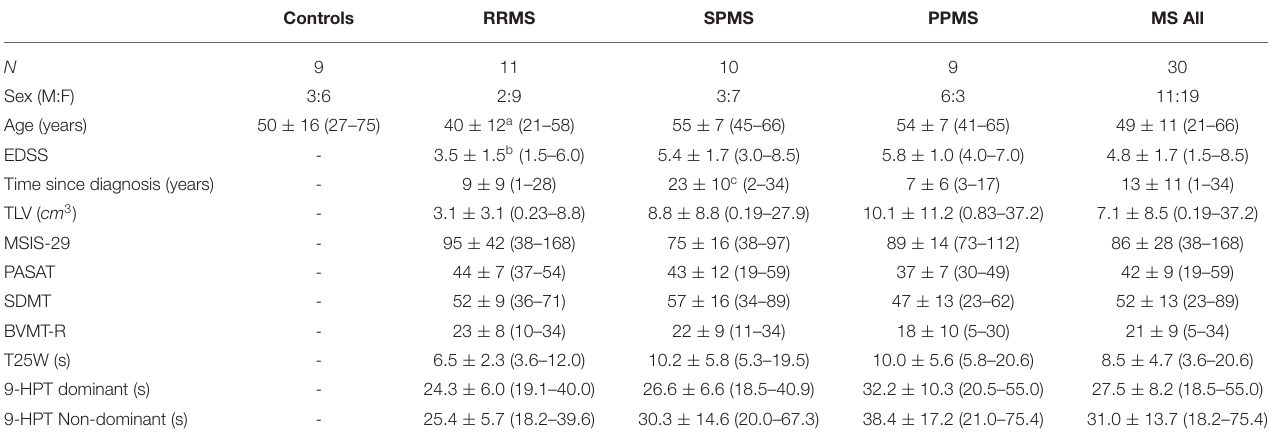
TABLE 1 | Participant demographics expressed as mean ± SD with (min-max) listed below. Controls RRMS